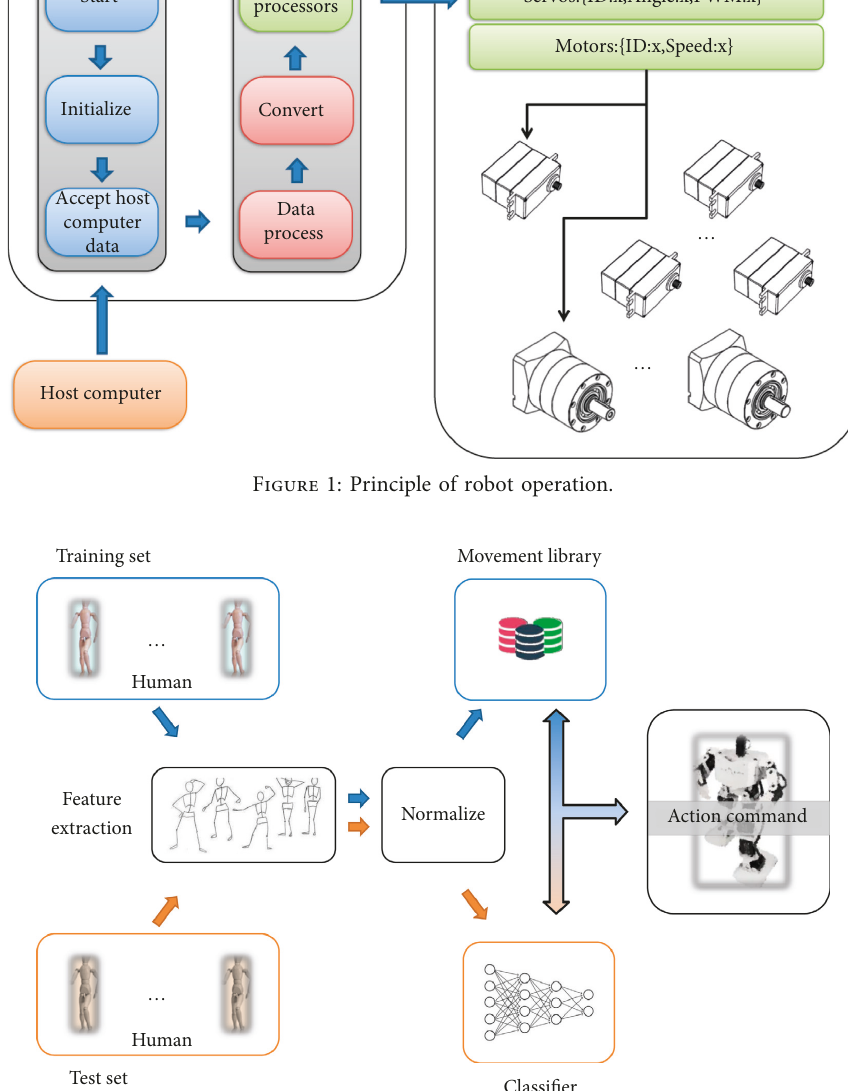
Figure 2: Action recognition